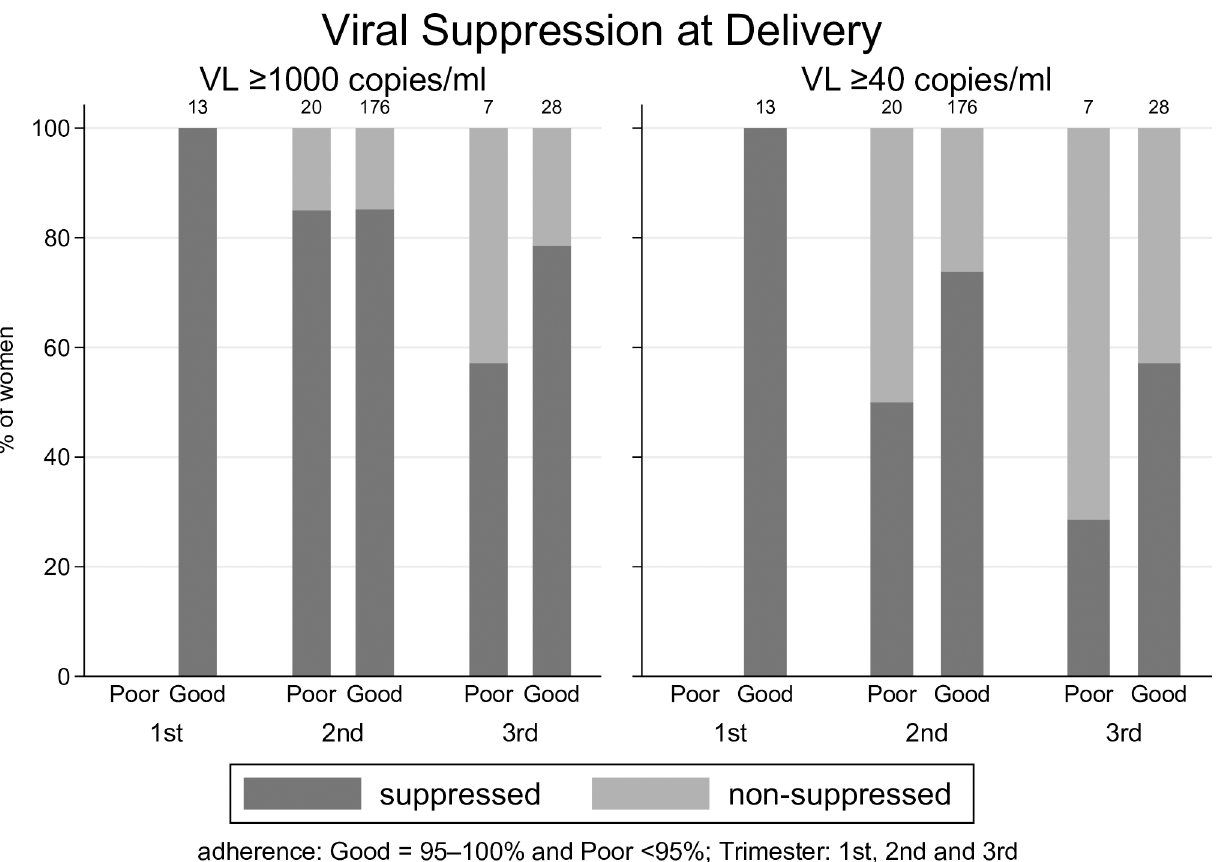
Fig 1. The distribution of women who achieved viral suppression at delivery stratified by level of ART adherence and the trimester at ART initiation.